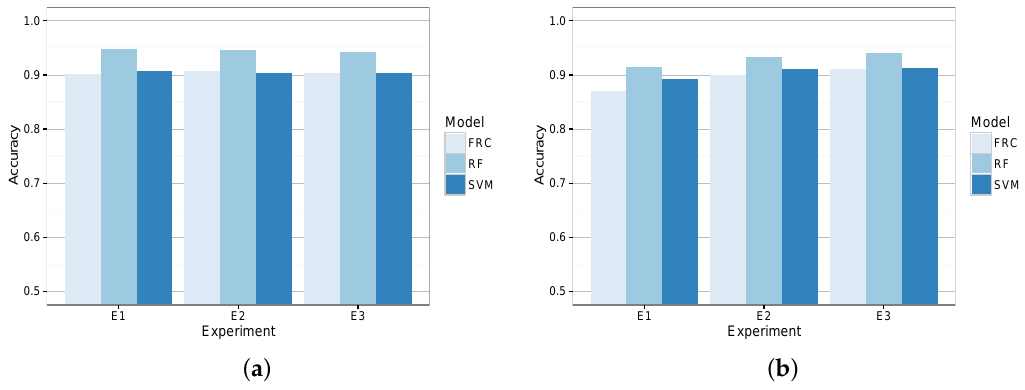
Figure 7. Coarse-grained classifier candidates’ accuracy. ( a ) Training error; ( b ) evaluation